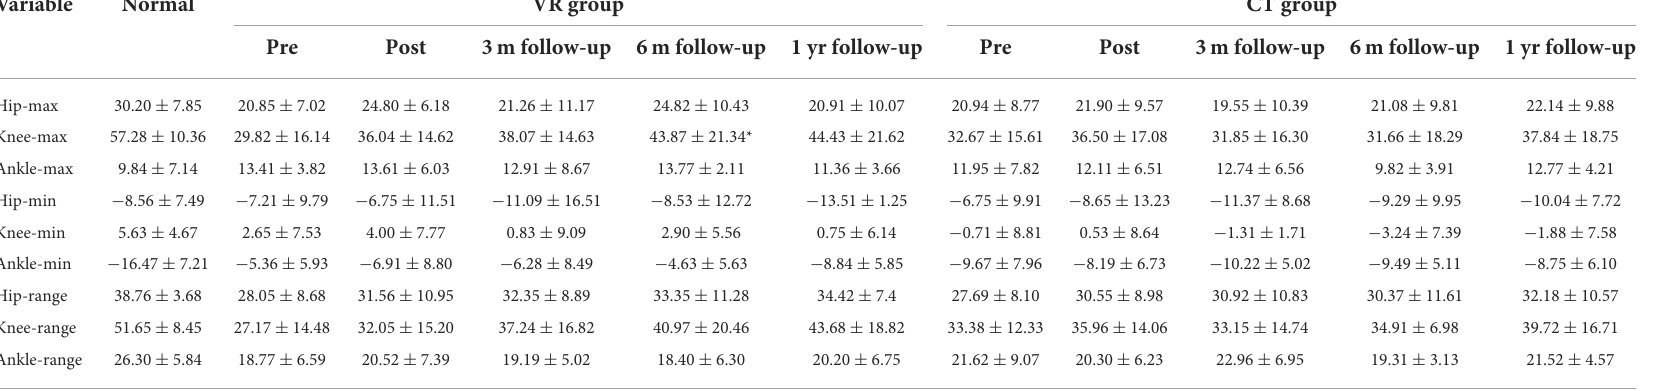
TABLE 5 Kinematic results in the sagittal plane of pre, post and follow-up among three groups.